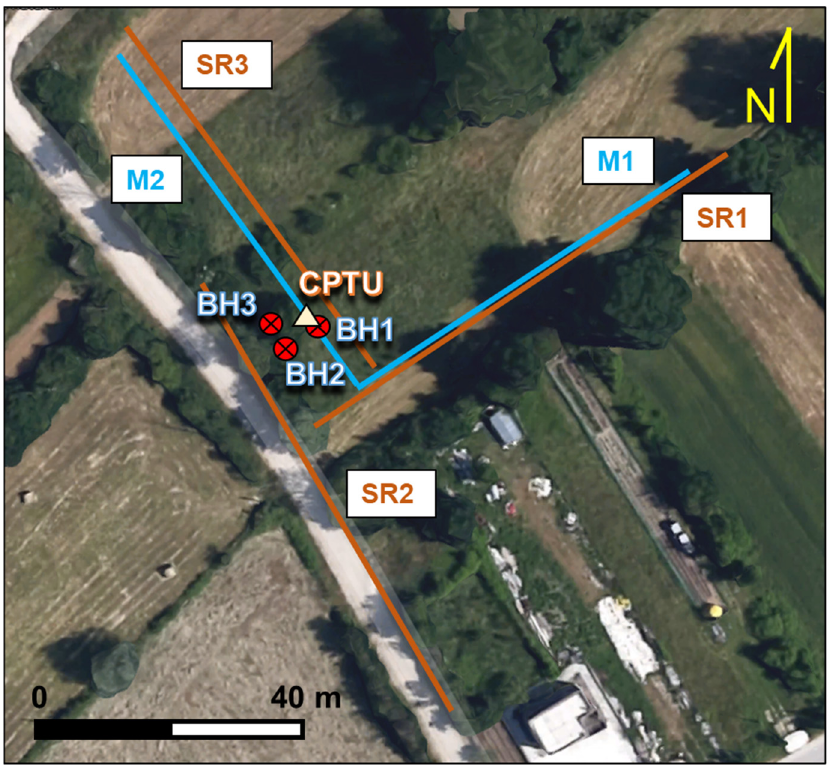
Figure 8. Plan view of the field investigation at the MDF site. BH = borehole; M = MASW; CPTU = cone penetration test; SR = Seismic refraction. CPTU = cone penetration test; SR = Seismic